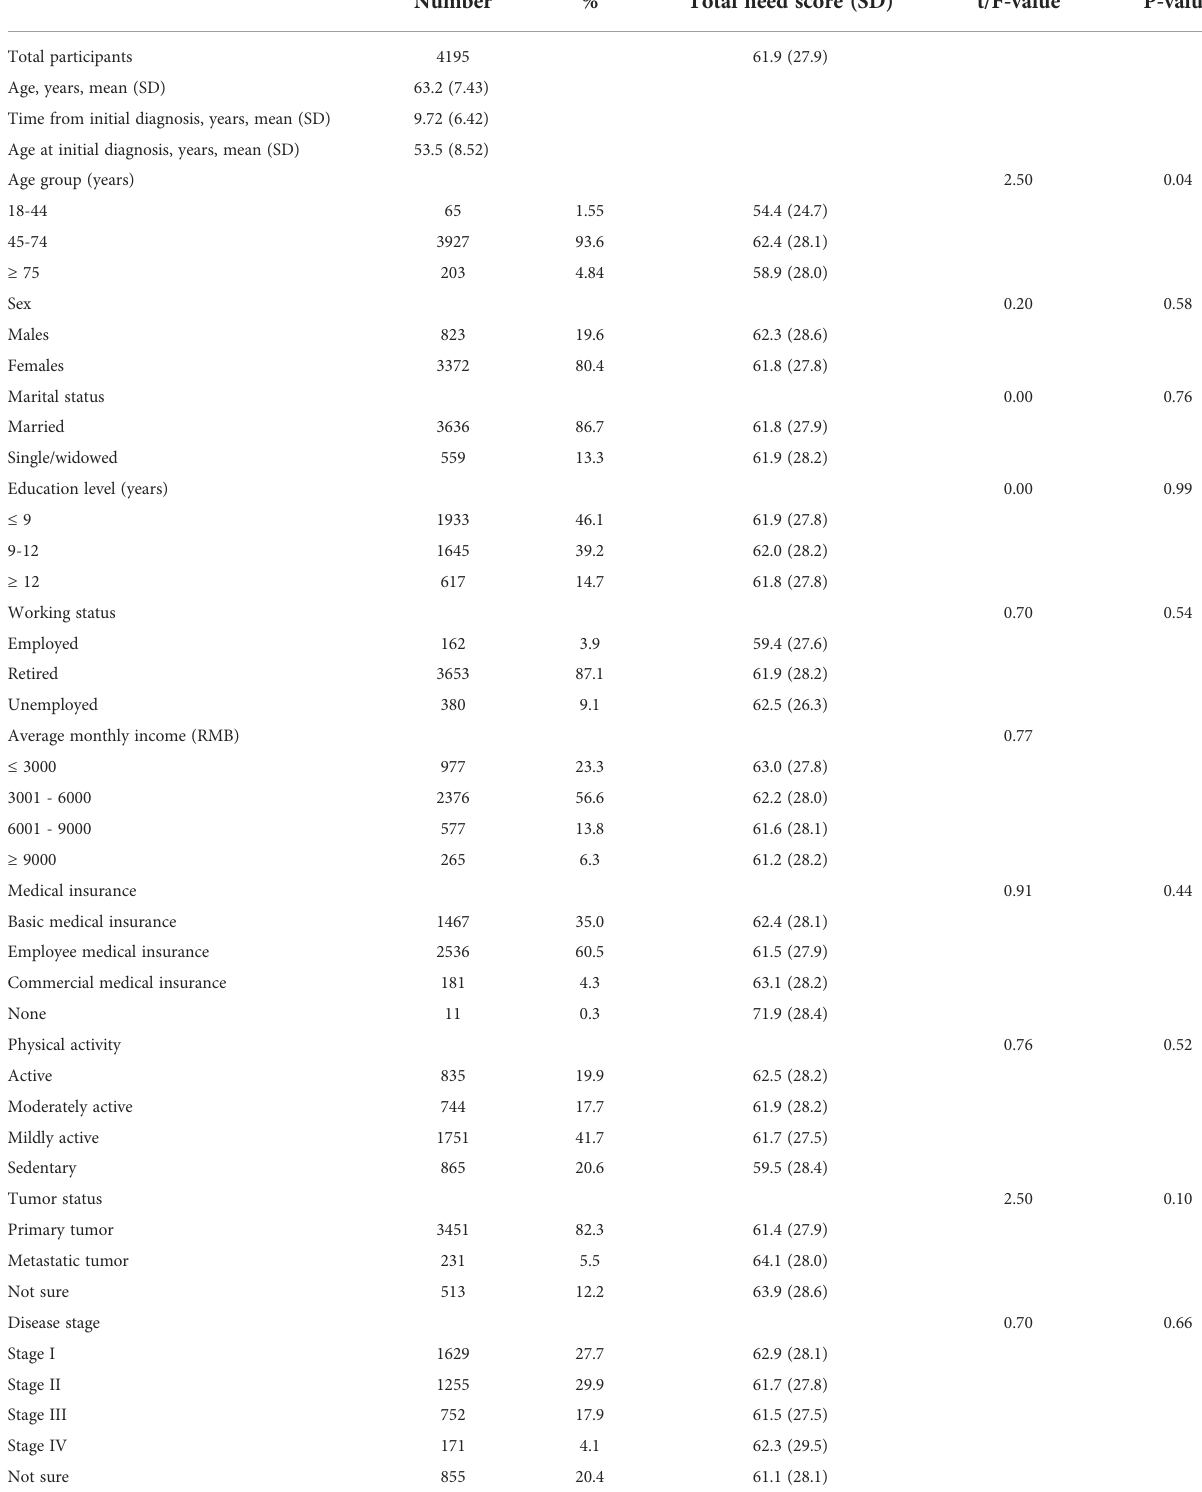
TABLE 1 Basic information and needs scores of study